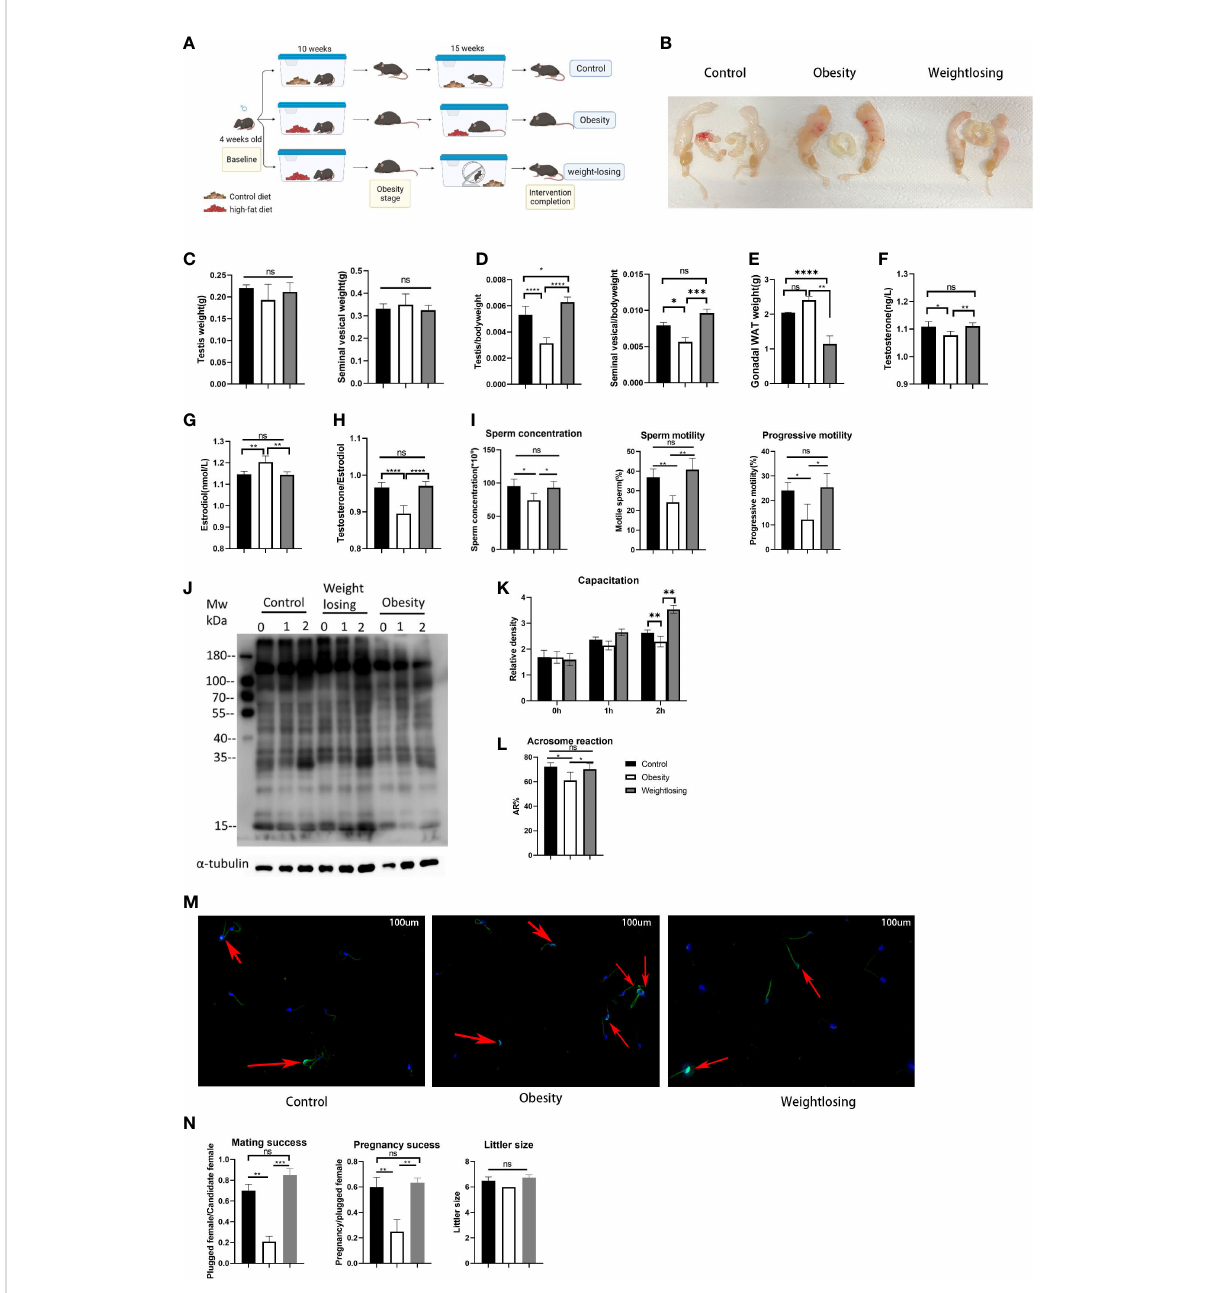
FIGURE 1 Effects of obesity and physical exercise intervention on reproductive morphology, reproductive hormones, sperm function and reproductive success. (A) , Schematic diagram of mouse breeding and intervention. (B) , Morphology of the mouse reproductive system. (C) , Testis weight (left) and testis index = testis weight/body weight (right). (D) , Seminal vesicle weight (left) and seminal vesicle index (right). (E) , Gonadal white adipose tissue weight. (F) , Serum testosterone (ng/L) levels. (G) , Serum estradiol (nm/L) levels. (H) , T/E2 and gonadal white adipose tissue weight (below). (I) , Analysis of semen traits include sperm concentration, motility and progressive motility. (J) , Western blot of sperm protein tyrosine phosphorylation to evaluate capacitation and its density. (K) , The relative density of the Western blot (p-tyrosine/ a -tubulin). (L) , The proportion of sperm without intact acrosomes in the three groups. (M) . FITC-PNA was used to show the sperm acrosome and the sperm fl agellum sheath. The red arrows indicate sperm with intact acrosomes that have not yet undergone acrosome reactions in the three groups. (N) . Mating success rate (left), pregnancy success (middle), litter size (right). One-way ANOVA was used to compare the differences among the three groups. Control: n=5, obesity: n=6, exercise: n=5. ns, P > 0.05, *P < 0.05, **P < 0.01, ***P < 0.001, ****P < 0.0001. Data are expressed as the mean ±